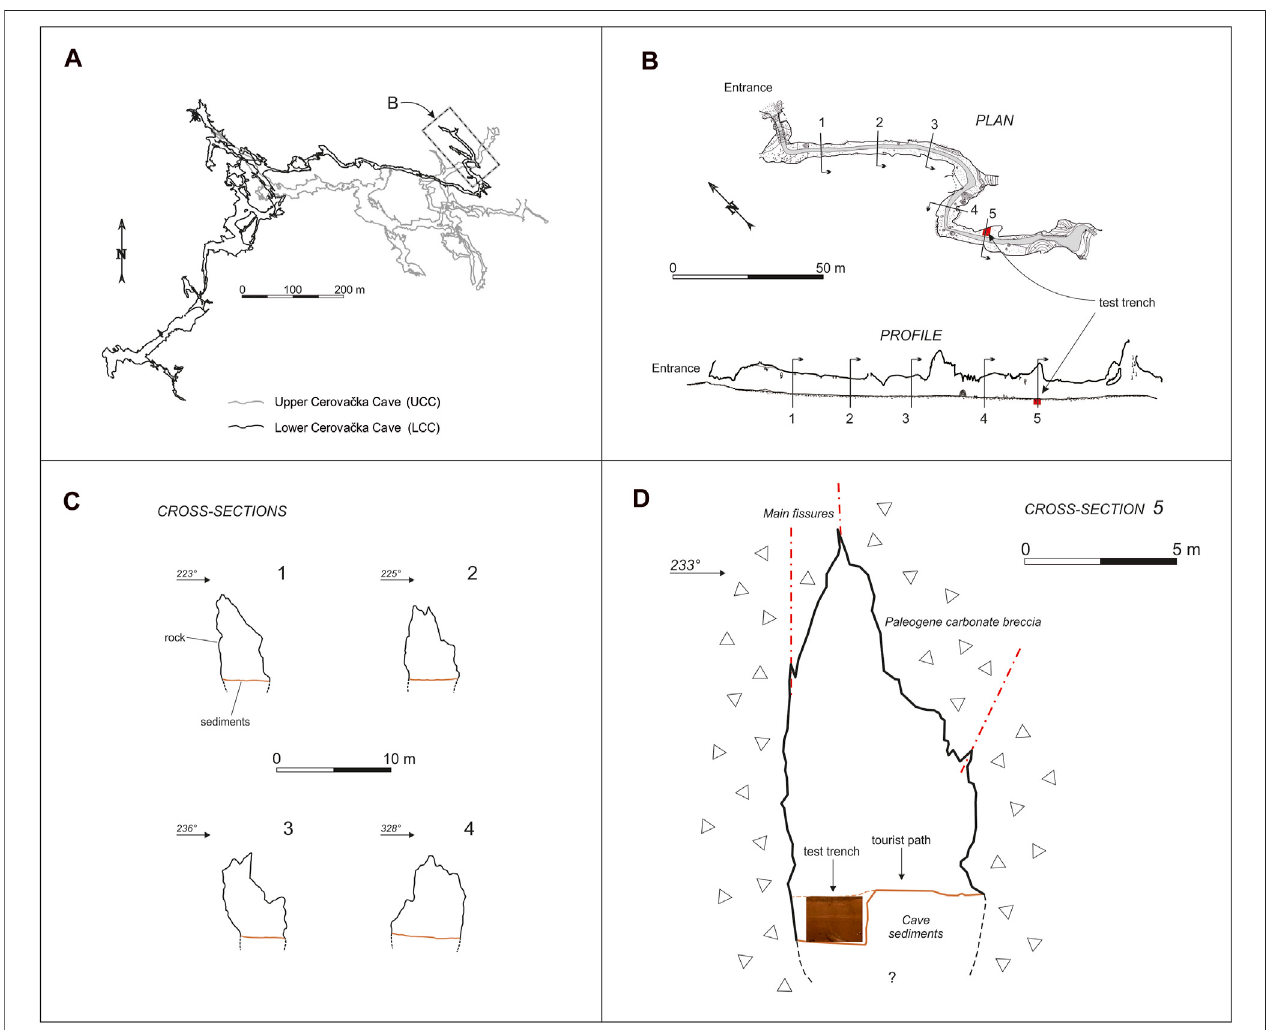
FIGURE 2 | (A) Simpli fi ed plan view of the Upper and Lower Cerova ˇ cka Cave, (B) plan view of the entrance part of the Lower Cerova ˇ cka Cave with the marked position of the researched test trench (cave survey according Bo ˇ ci´c et al., 2016), (C) selected cross-sections (1 – 4), and (D) cross-section of the cave channel at the location of the test